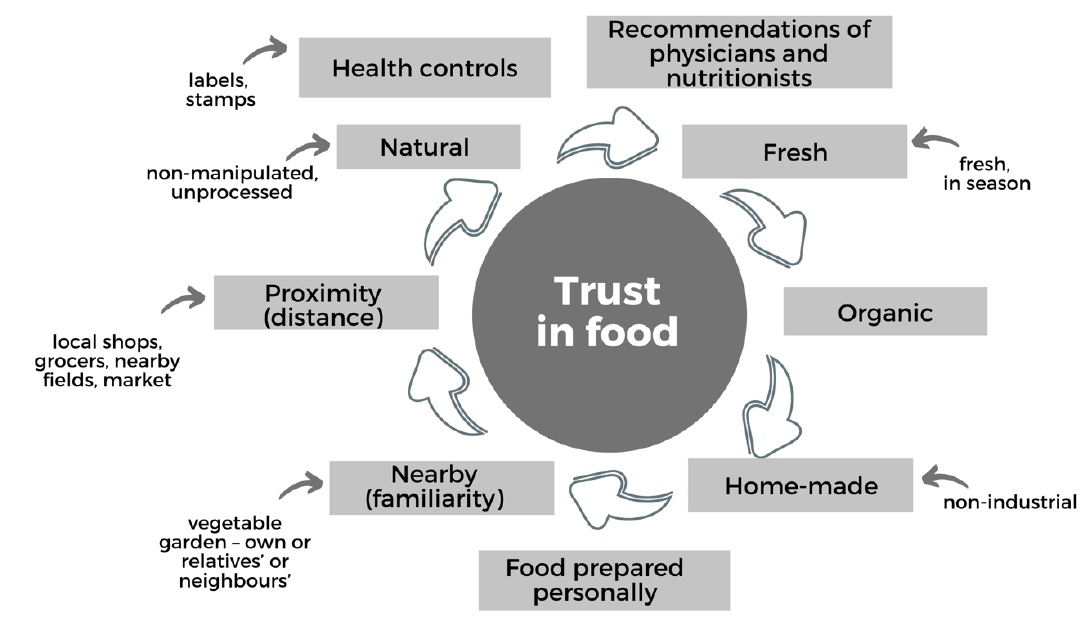
Figure 3. Categories and items arising from the focus groups in relation to trust in food.